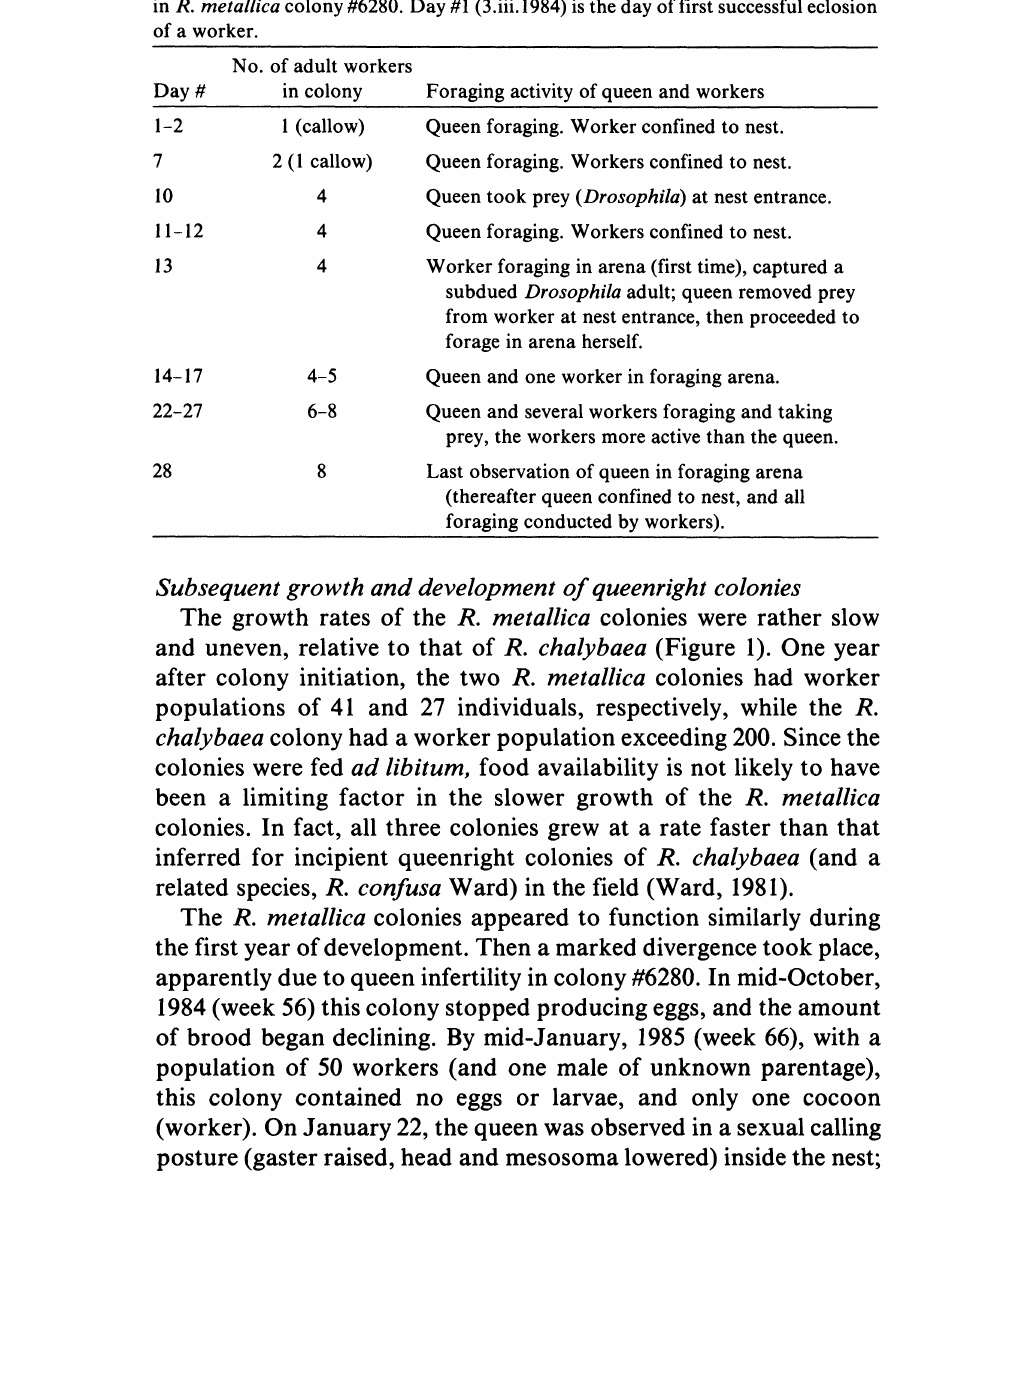
Table 2. Observations on foraging activity ofthe queen and first eclosing workers in R. metallica colony #6280. Day #1 (3.iii. 1984) is the day of first successful eclosion of a